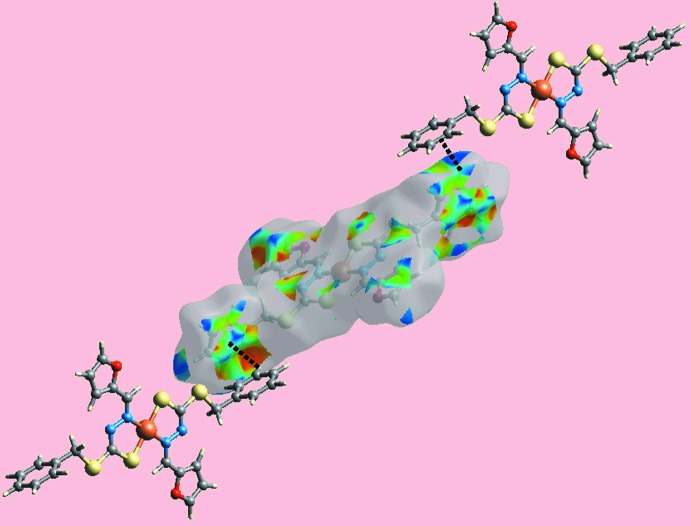
A view of the Hirshfeld surface with the shape-index property highlighting C—H⋯π/π⋯H—C contacts by black dotted lines.